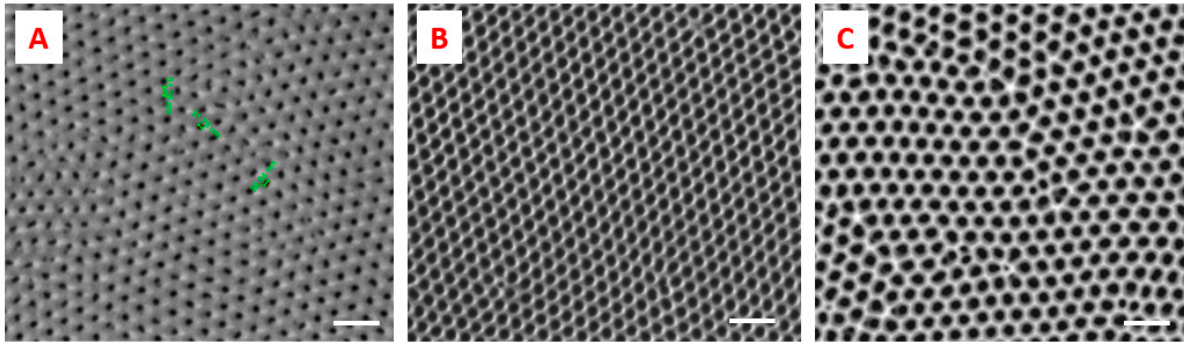
Figure 2. SEM micrographs. Porous alumina membranes with a distance between pores of 60 nm ( A ), 85 nm ( B ) and 95 nm ( C ). The white scale bar is 200 nm.